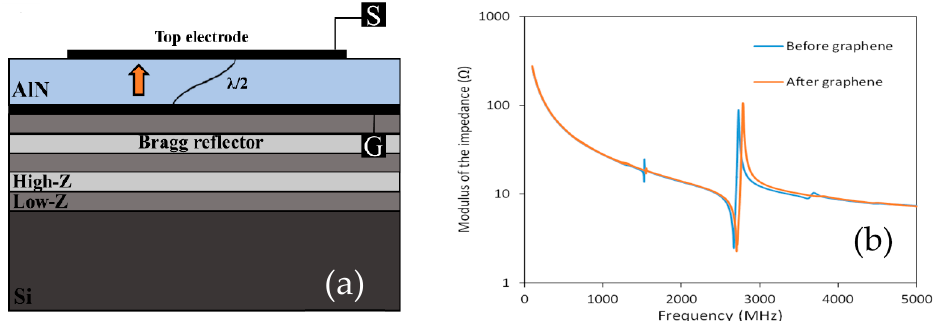
Figure 1. ( a ) Cross-section of a typical AlN-based SMR showing the Ir/AlN/Mo/Ni piezoelectric stack and the acoustic reflector and ( b ) impedance of a device before and after the growth of